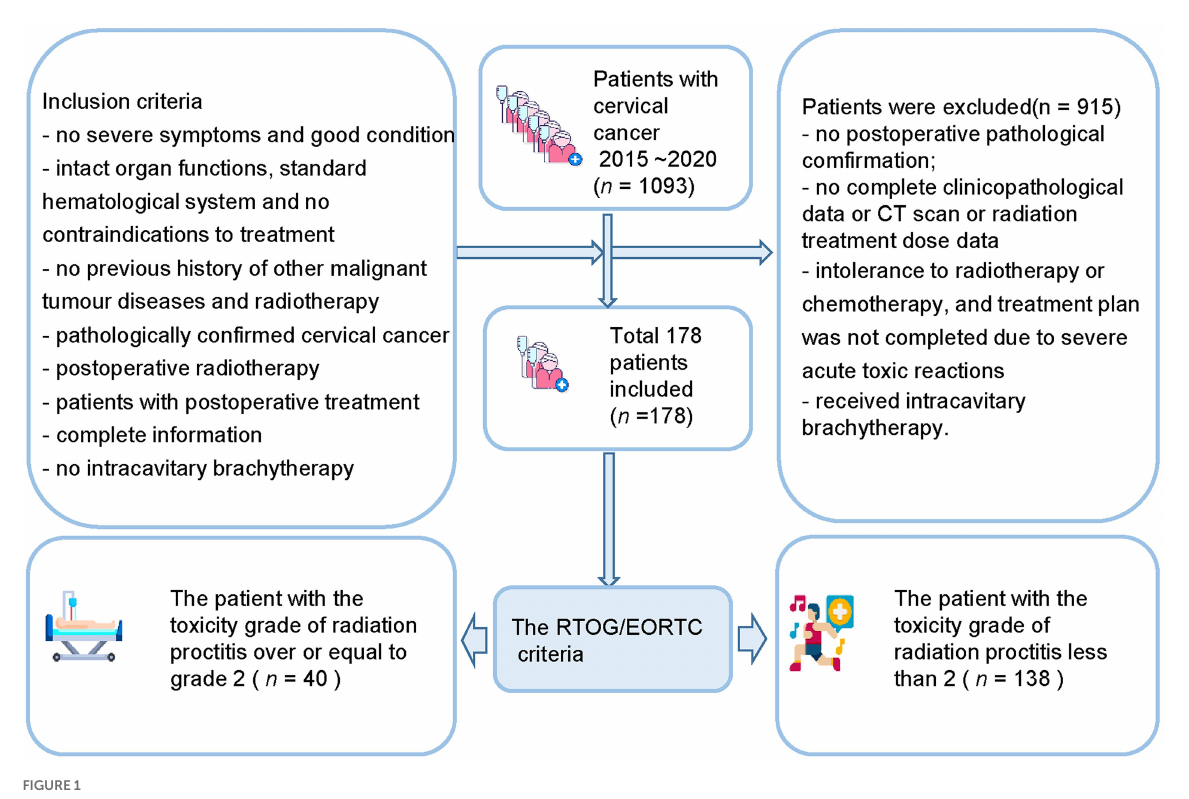
FIGURE 1 Flow diagram of the study enrolment